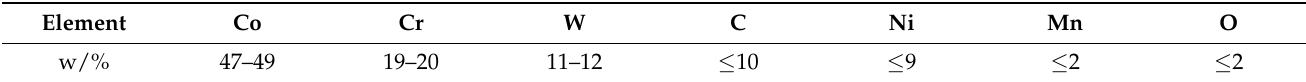
Table 4. Mechanical properties of cobalt–chromium alloy cardiovascular stent tubes.